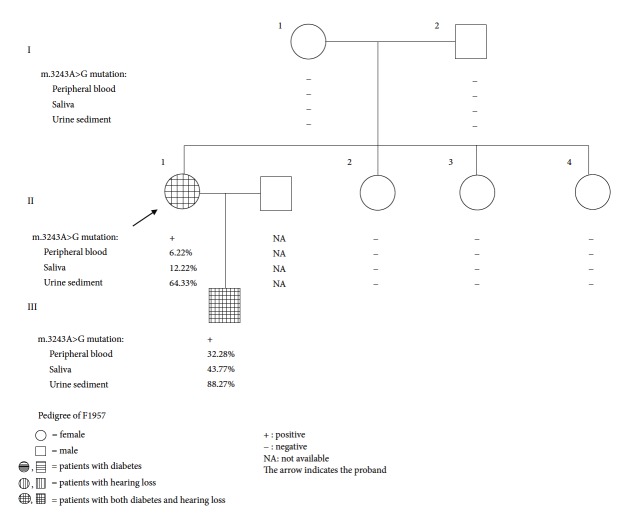
Pedigree of F1957.